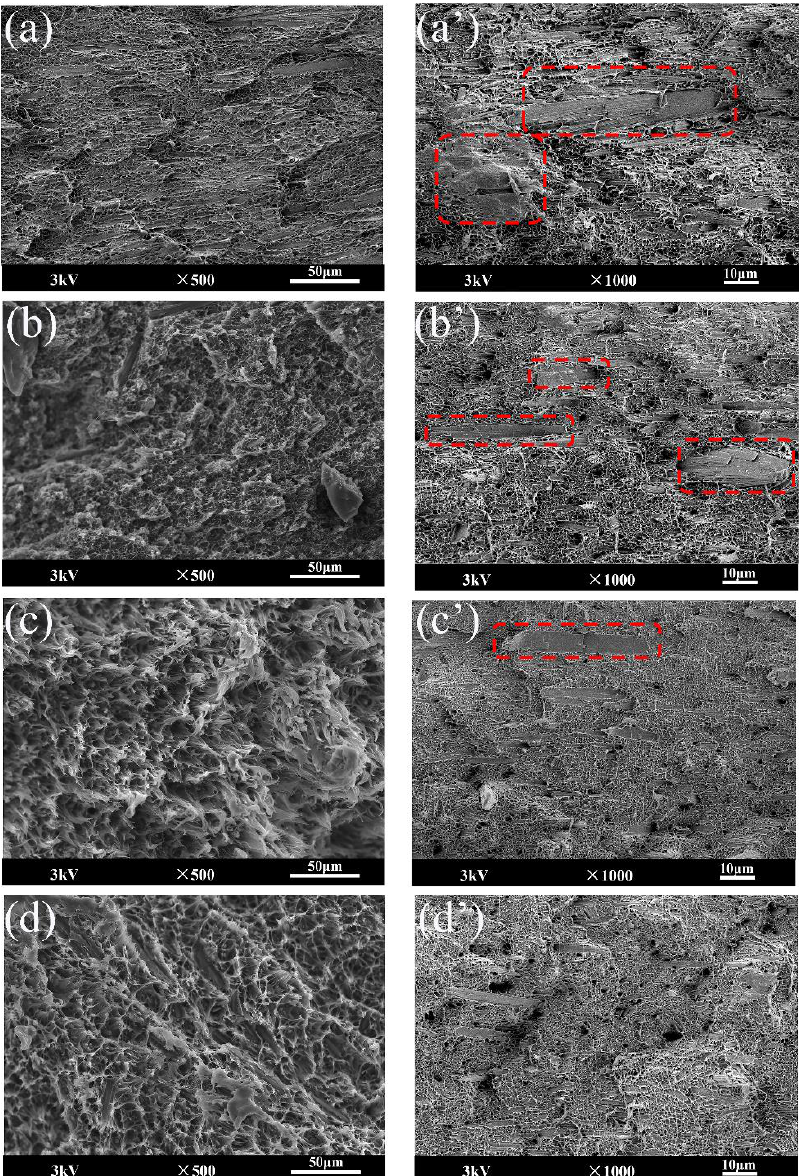
Figure 6. SEM micrographs of ( a ), ( a’ ) HDPE/MOSw, ( b ), ( b’ ) HDPE/MOSw@SiO 2 , ( c ), ( c’ ) SEM micrographs of ( a ), ( a’ ) HDPE/MOSw, ( b ), ( b’ ) HDPE/MOSw@SiO 2 , HDPE/MOSw@SiO 2 @KH570, ( d ), ( d’ ) HDPE/MOSw@SiO 2 @PDA. ( c ), ( c’ ) HDPE/MOSw@SiO 2 @KH570, ( d ), ( d’ ) HDPE/MOSw@SiO 2